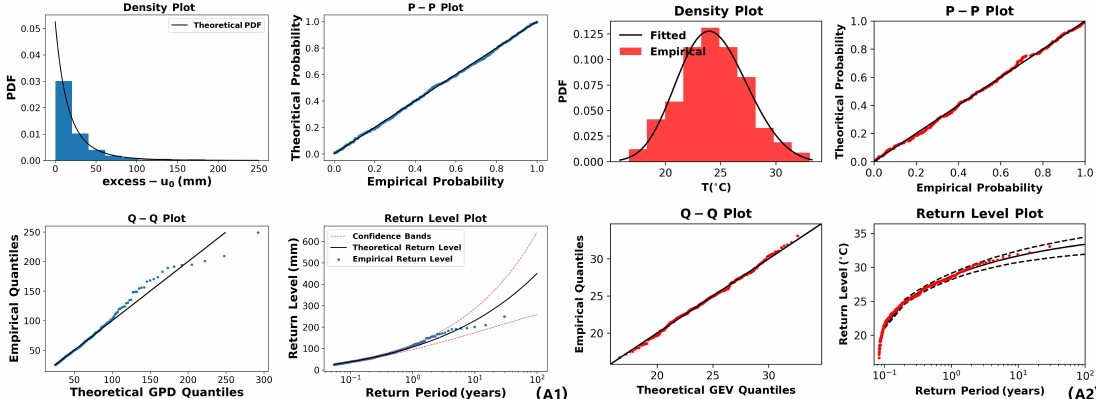
Figure A7. Diagnostic plot for Serra San Bruno station. ( A1 ) Rainfall diagnostic plot. ( A2 ) temperature diagnostic